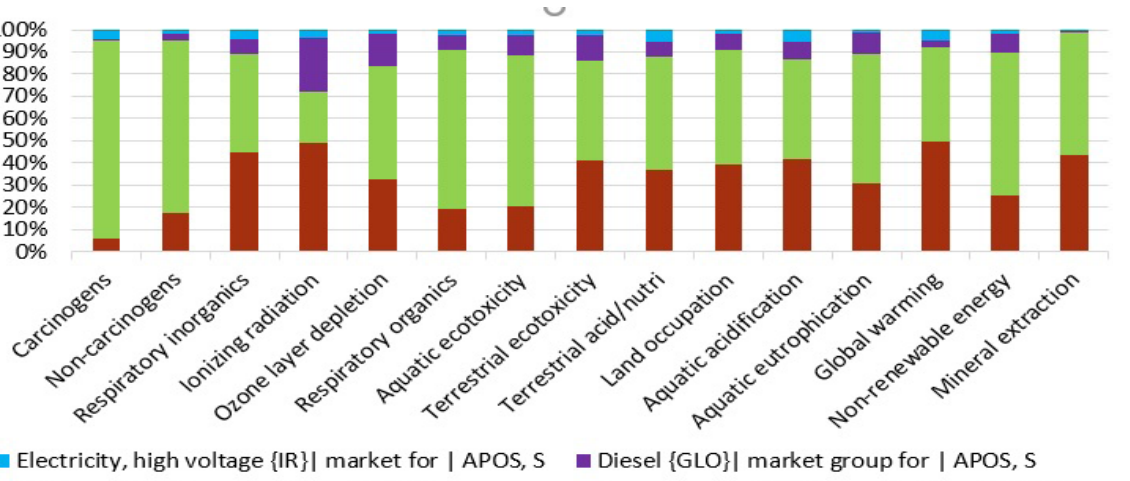
Figure 11. Results of applying impact 2002+ characteristic coefficients in calculating impacts